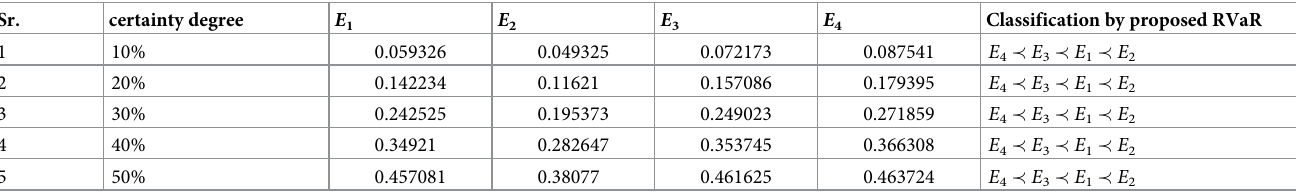
Table 2. RVaR results under PIVHF